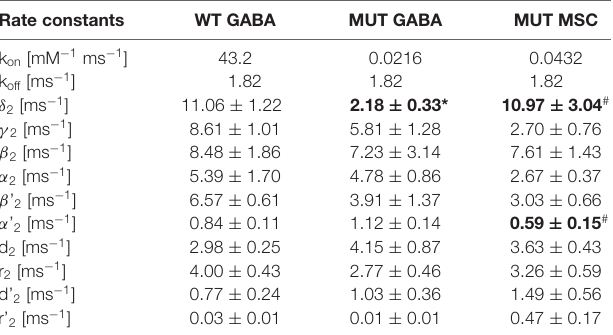
TABLE 2 | Kinetic model simulations for the single-channel activity based on single-channel kinetic model scheme shown in Figure 7A . Rate